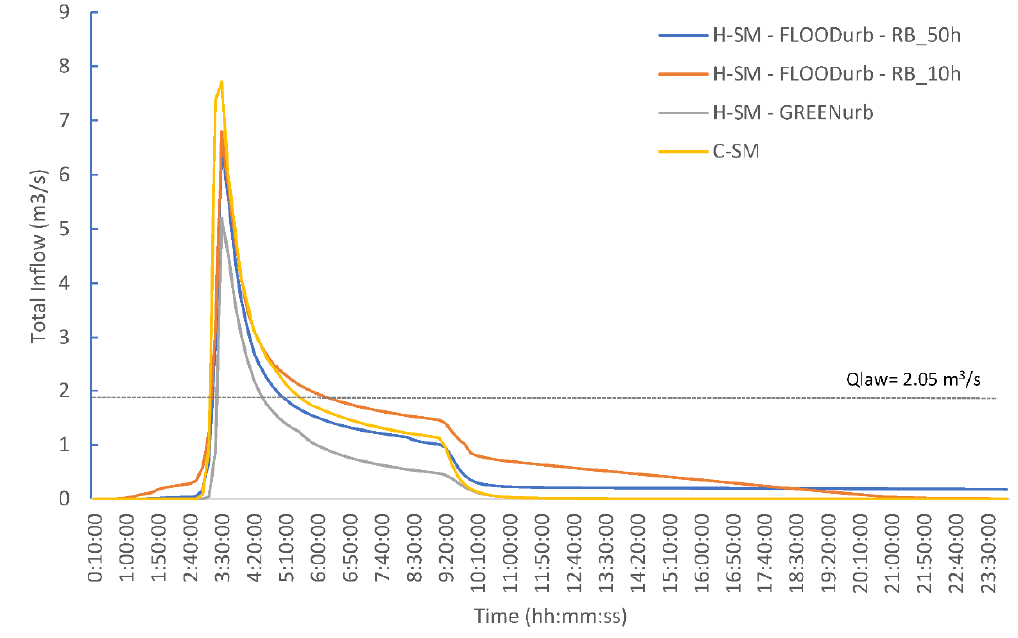
Figure 5. Hydrographs CSO 1019 (Catchment A) under 10-year rainfall event.